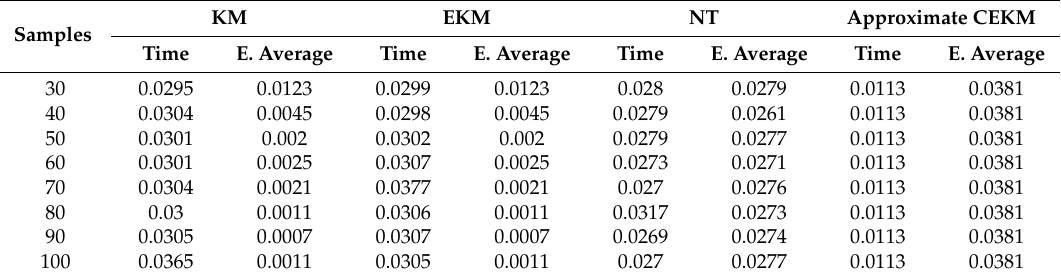
Table 8. Type reduction comparison.